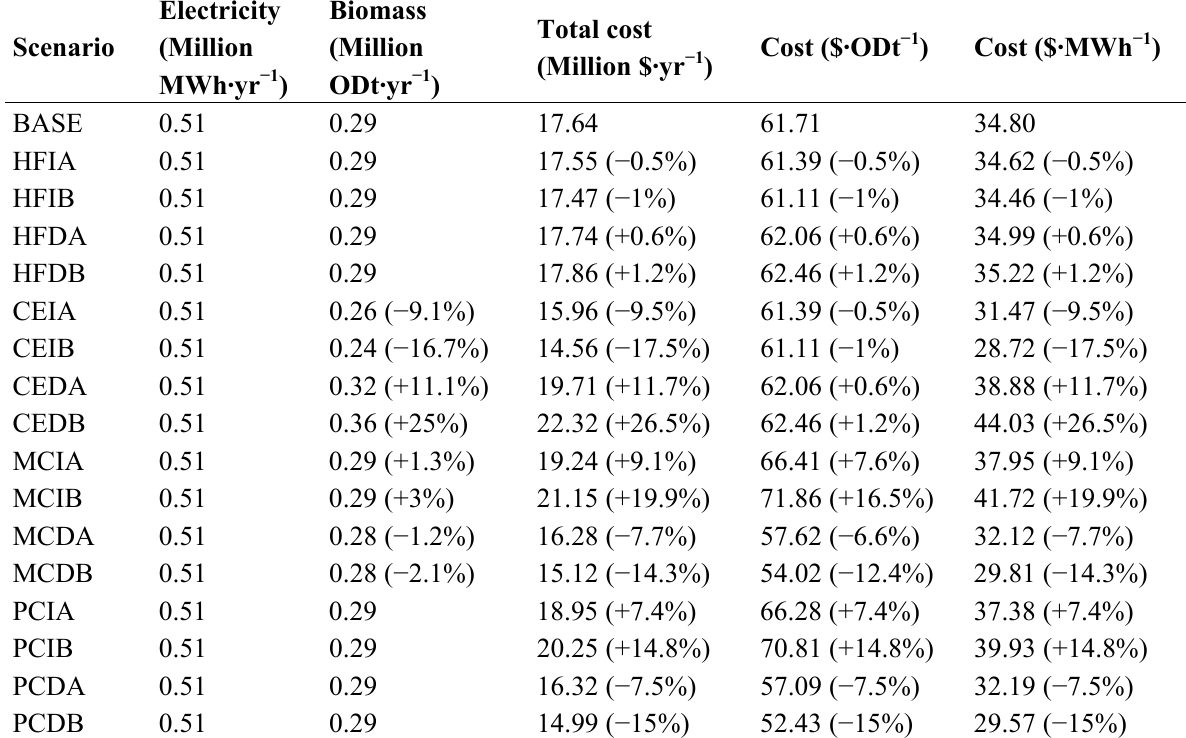
Table 3. Sensitivity analyses on the total amount of annual biomass harvesting, total biomass procurement cost, unit biomass procurement cost and the unit electricity production cost. Numbers in brackets represent % change from the BASE